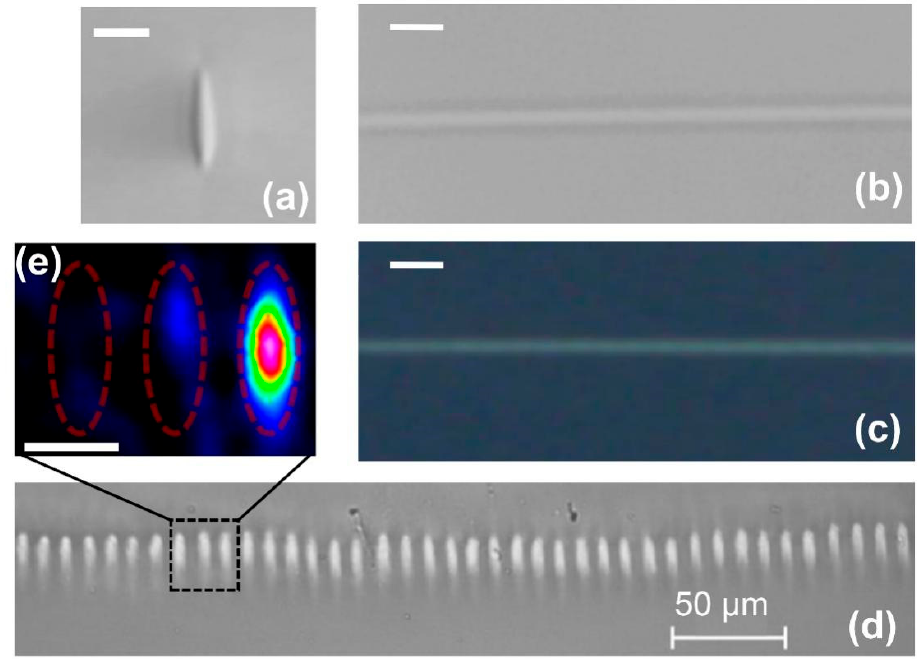
Figure 3. Microscopy investigation of BWGs: cross-section image ( a ) and corresponding top-view ( b ); the same top-view in crossed-polarized light ( c ); cross-section image of the BWGs array in a single PG plate ( d ); investigation of cross-talk between BWGs by the caption of intensity distribution at the BWG output ( e ). The scale bar is 10 μ m.